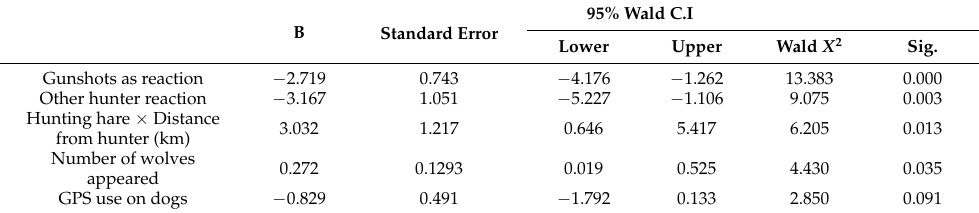
Figure 5. Frequency distribution of the illegal poison bait use locations over the dog predation risk classes (1–10 equal class interval). Table 2. Factors related to the severity of wolf attacks on hunting dogs listed in descending order of importance according to Wald Chi-square statistic (GLM with ordinal probit link function X 2 likelihood ratio test = 24.945, d.f = 5, p < 0.0001, AICc = 75.703 for the “verified” × “all interactions” data set).